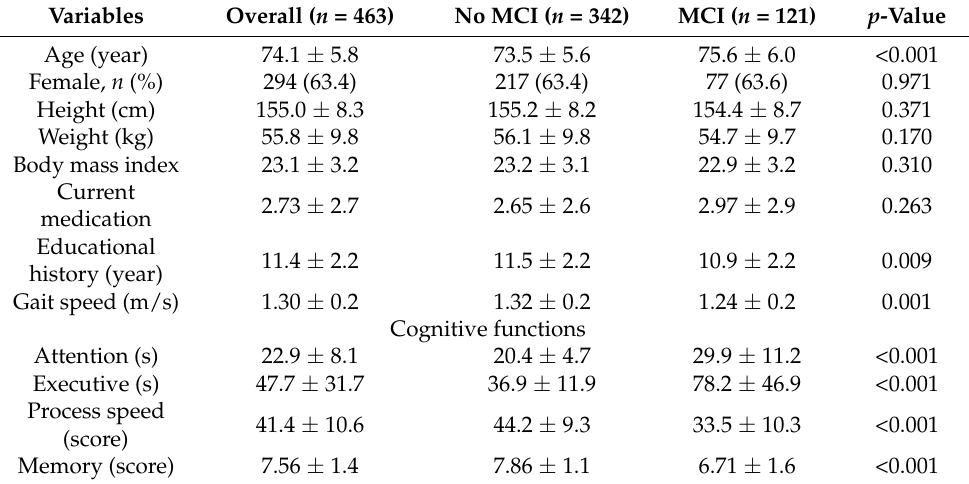
Table 1. Characteristics of the demographic data including cognitive functions.